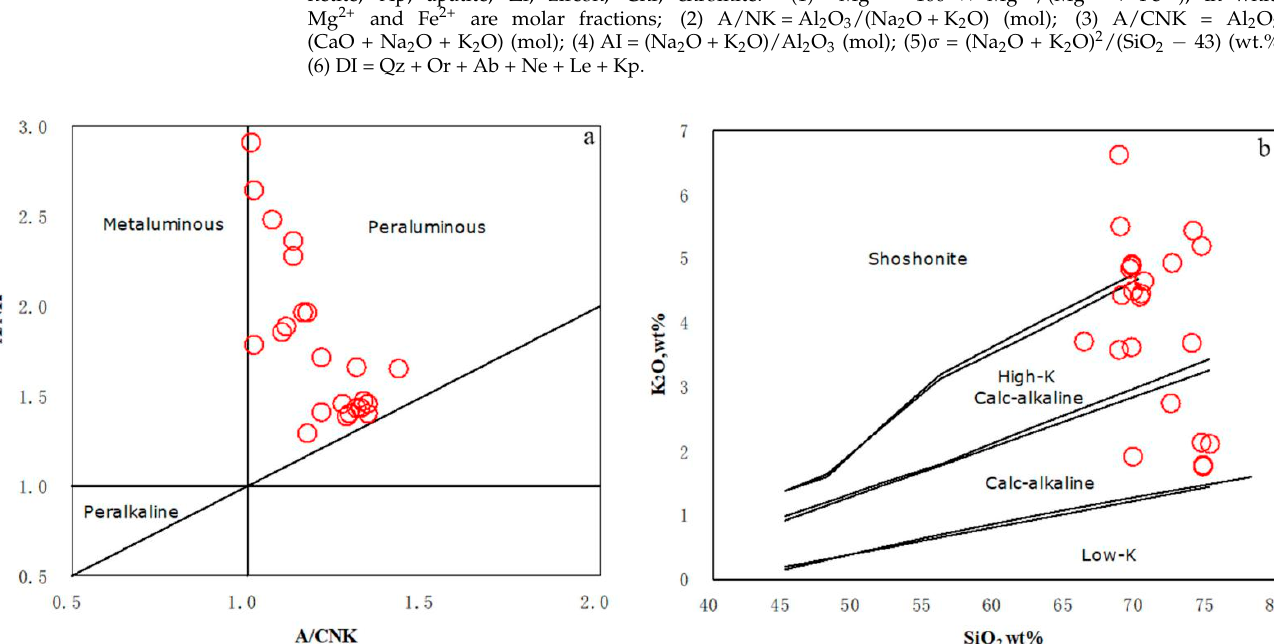
Figure 4. Total alkali vs. silica (TAS) plot of the Dahongliutan pluton samples (according to Mid- dlemost, et al. [16]). 4.3. Trace Element Contents Table 2 lists the trace element compositions of the samples. Among the large ion lithophile elements (LILEs), Rb is enriched and Sr is depleted (Figure 5a). Among the high field strength elements (HFSEs) Th is enriched, while Ta and Nb are depleted. The observed Sr depletion may be related to the fractional crystallization of plagioclase. HFSE depletion indicates that the magma source was predominantly crustal material.